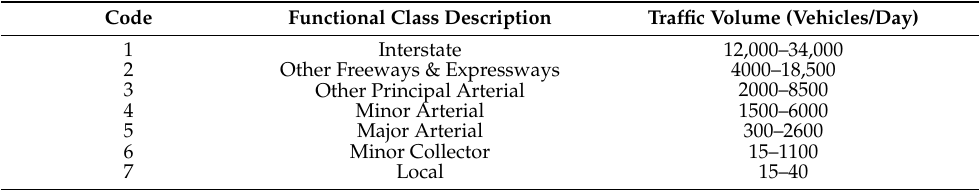
Table A1. Federal Highway Administration functional class description codes used to estimate traffic volume for roads in Rhode Island.